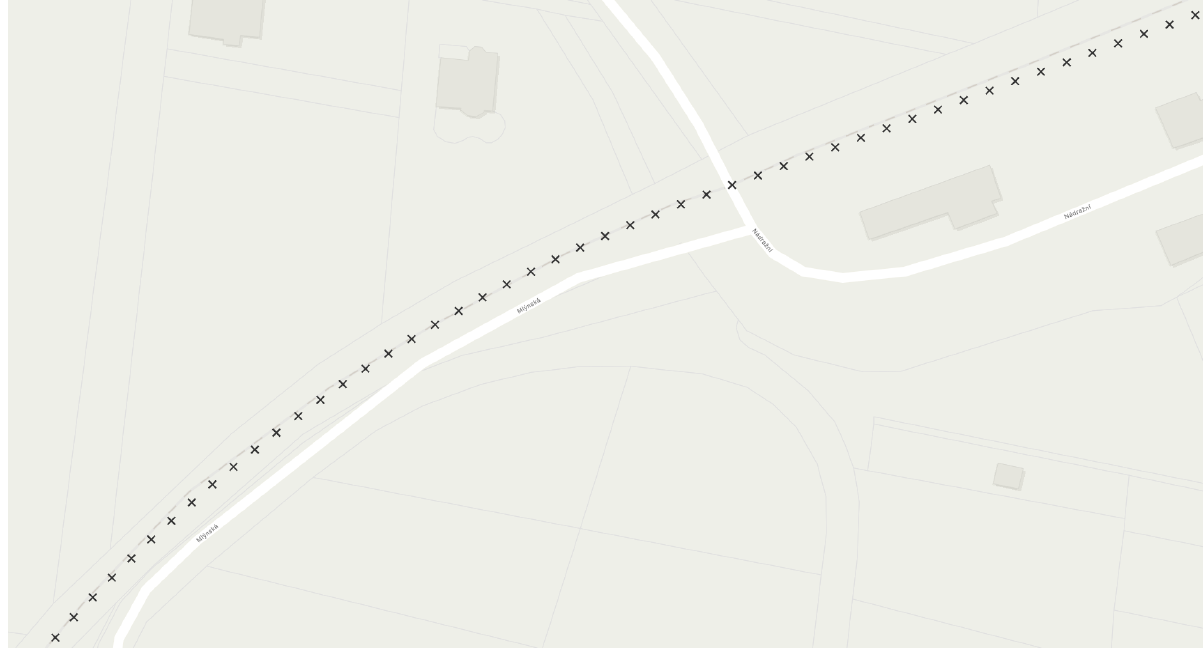
Figure 2. Individual points of the track obtained through geodetic survey visualised in the ArcGIS Pro Software